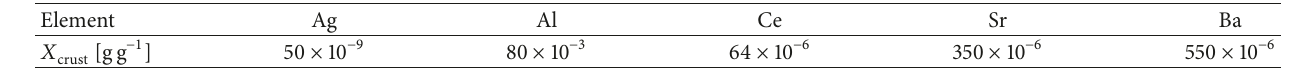
Table 2: Mean crustal concentration ( 𝑋 crust ) to compute CEF (equation (1))